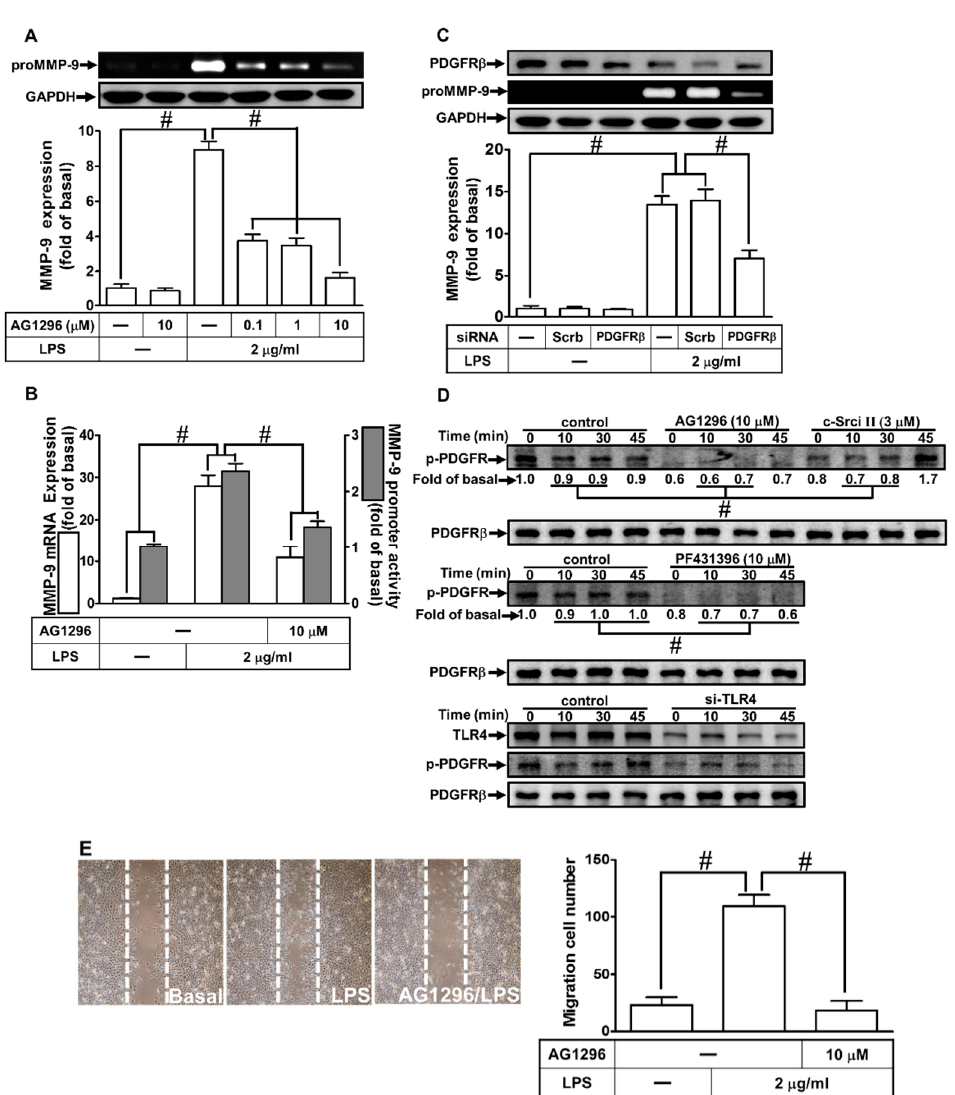
Figure 5. Platelet-derived growth factor receptor (PDGFR) β was involved in LPS-induced MMP-9 expression and cell migration. ( A ) RBA-1 cells were pretreated with AG1296 (0.1, 1, and 10 μ M) for 1 h, and then incubated with LPS (2 μ g/mL) for 24 h. The levels of MMP-9 were determined by gelatin zymography. The GAPDH level of cell lysates was assayed by western blot. ( B ) Cells were pretreated with AG1296 (10 μ M) for 1 h, and then incubated with LPS (2 μ g/mL) for 4 h for mRNA expression or 6 h for promoter activity. The mRNA expression and promoter activity of MMP-9 were determined